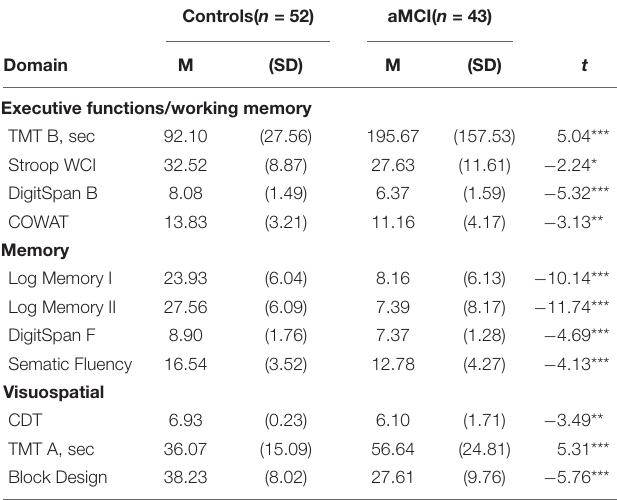
TABLE 2 | Means and standard deviations from neuropsychological tests by cognitive domain.